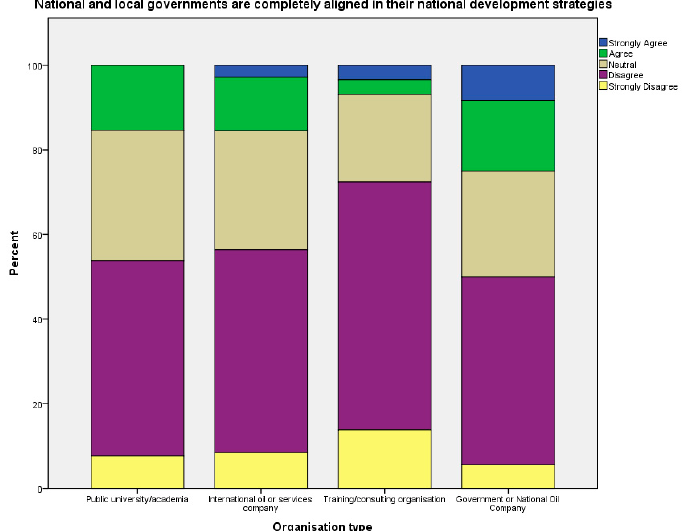
Figure 2. Responses by organization type to “national and local governments are completely aligned in their national development strategies”.